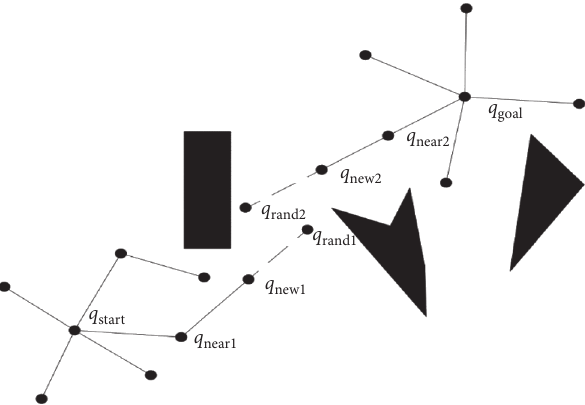
Figure 5: Schematic diagram of basic Bi-RRT algorithm.